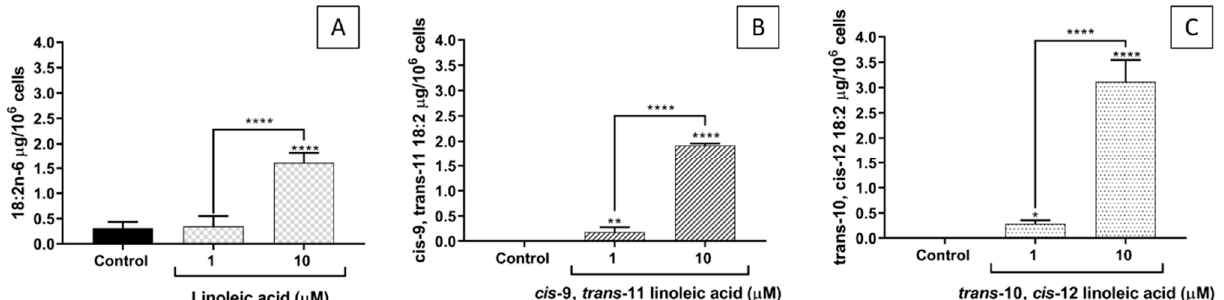
Figure 1. Viability of EA.hy926 cells after preincubation for 48 h with supplemented DMEM containing 0.1% of ethanol (Control) or different concentrations (1, 10, or 50 µ M) of linoleic acid ( A ), cis -9, trans -11 linoleic acid ( B ), trans -10, cis -12 linoleic acid ( C ), followed by incubation with (+) or without ( − ) tumour necrosis factor (TNF)- α (1 ng/mL) for 24 h: TNF- α ( − ) (black bars) refers to cells cultured in the absence of TNF- α while TNF- α (+) (hatched bars) refers to cells cultured with TNF- α . Bars are mean ± SD of 9 samples from 3 experiments. Data were analysed using two-way ANOVA with Tukey’s post hoc test. **** p < 0.0001 vs Control.